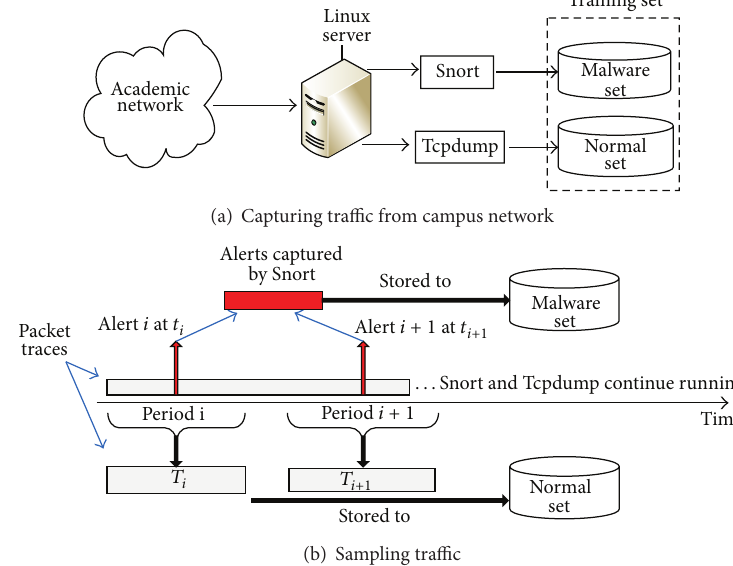
Figure 5: Dataset preparation.